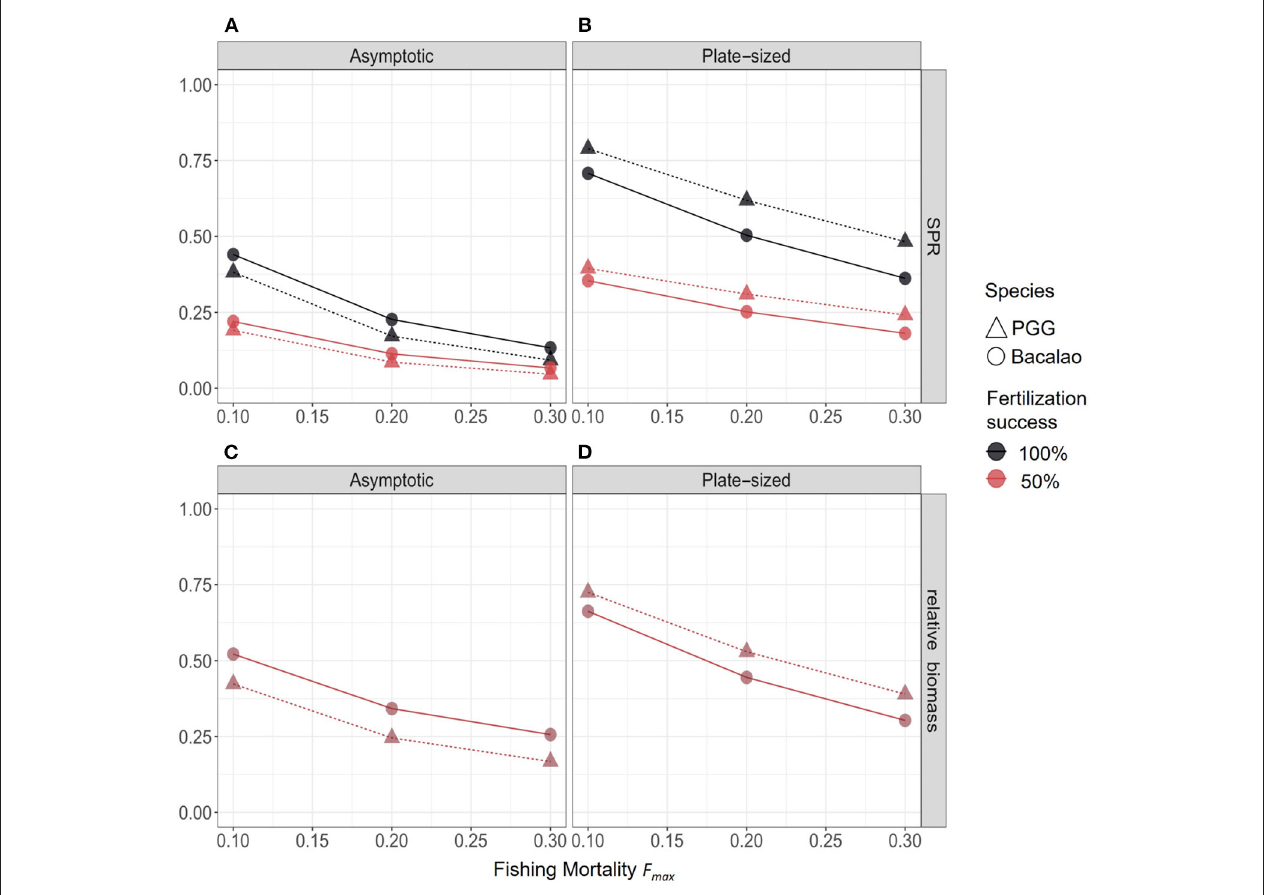
FIGURE 4 | Biological reference points for PGG (triangles) and bacalao (circles), with different selectivity and fertilization scenarios. The top row (A,B) shows the SPR for each selectivity scenario, and bottom row (C,D) shows the biomass reference point. Colors represent fertilization success; note that for biomass, the two colors are on top of one